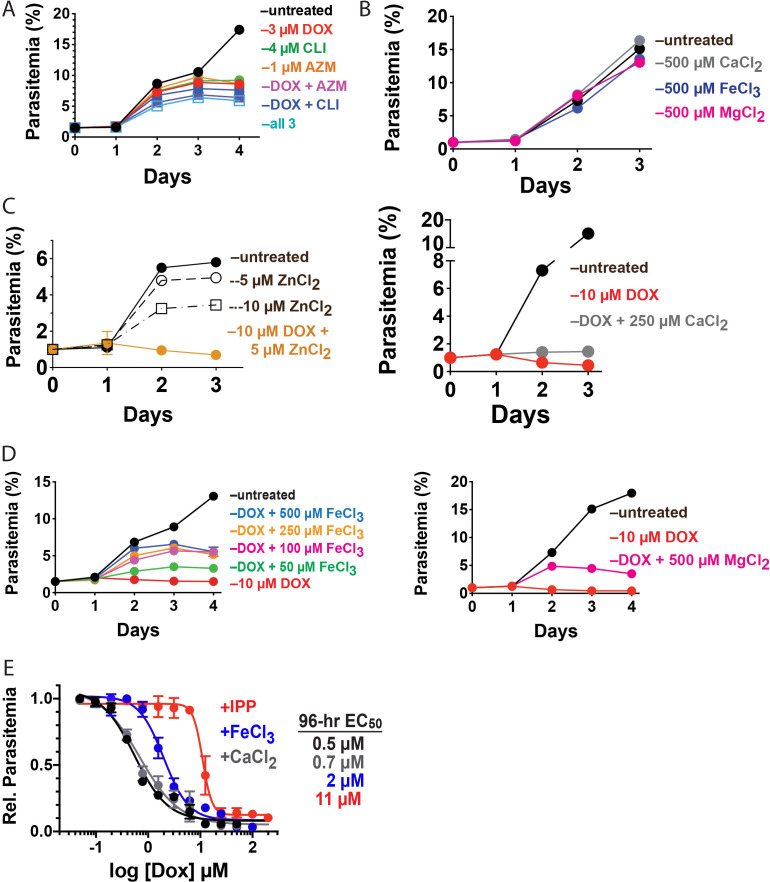
Additional, independent growth assays with DOX, other antibiotics, and metals.Additional continuous growth assays of synchronized Dd2 parasites treated with (A) DOX, clindamycin (CLI), and/or azithromycin (AZM); (B) 500 µM of CaCl2, MgCl2, or FeCl3 alone; (C) 10 µM DOX and 5 µM ZnCl2 or 250 µM CaCl2; (D) 10 µM DOX treated with 50–500 µM FeCl3 or 500 µM MgCl2. Individual data points are the ave ± SD from two to four biological replicates. (E) 96 hr growth-inhibition assays for DOX-treated D10 parasites in the absence or presence of 200 µM IPP, 500 µM FeCl3, or 500 µM CaCl2. Parasites were synchronized by magnet purification of schizonts followed by 5 hr incubation with uninfected erythrocytes and treatment with 5% D-sorbitol. Data points are the ave ± SD of 3 biological replicates.